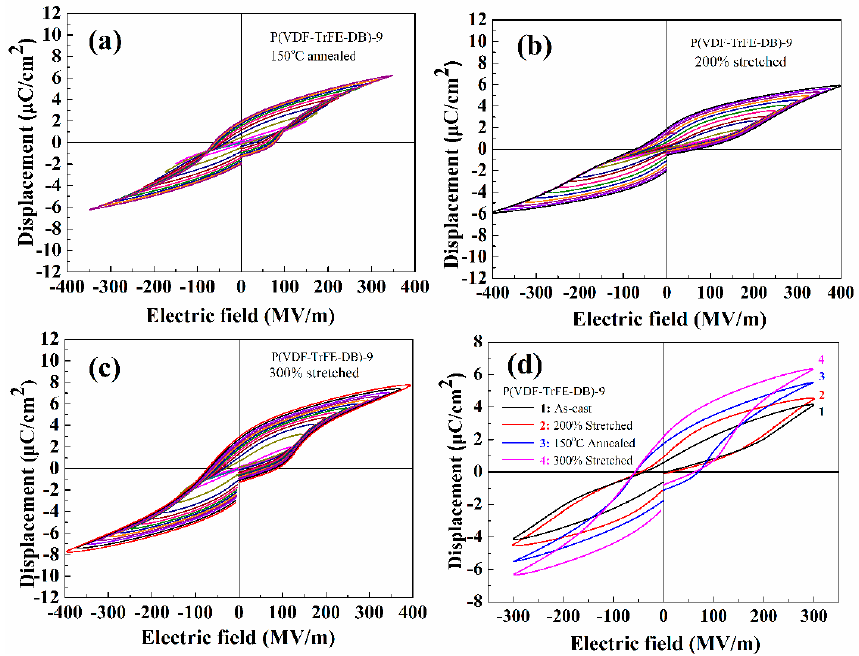
Figure 11. The bipolar D–E loops of P(VDF-TrFE-DB)-9 annealed at 150°C ( a ), P(VDF-TrFE-DB)-9 at room temperature stretched 200% ( b ), stretched 300% ( c ), and comparison of D–E loops for P(VDF-TrFE-DB)-9 treated under different conditions at 10 Hz and 300 MV·m -1 ( d ).